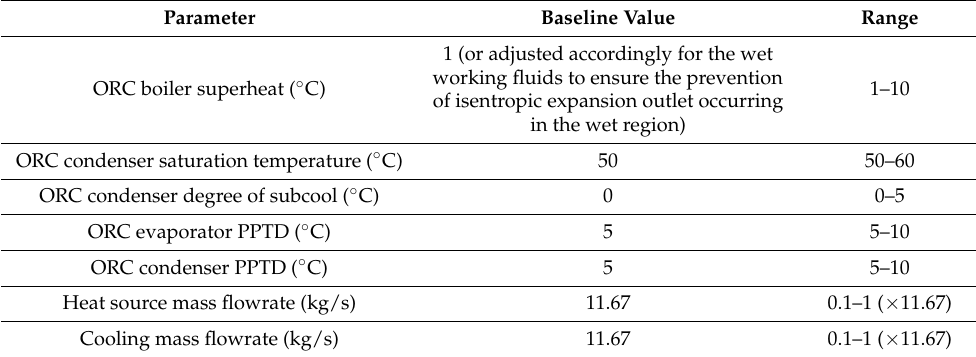
Table 6. Baseline operating conditions and the range of